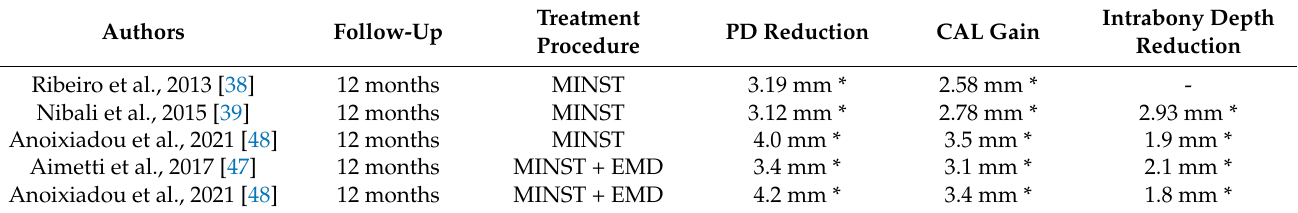
Table 1. Results of MINST and MINST +